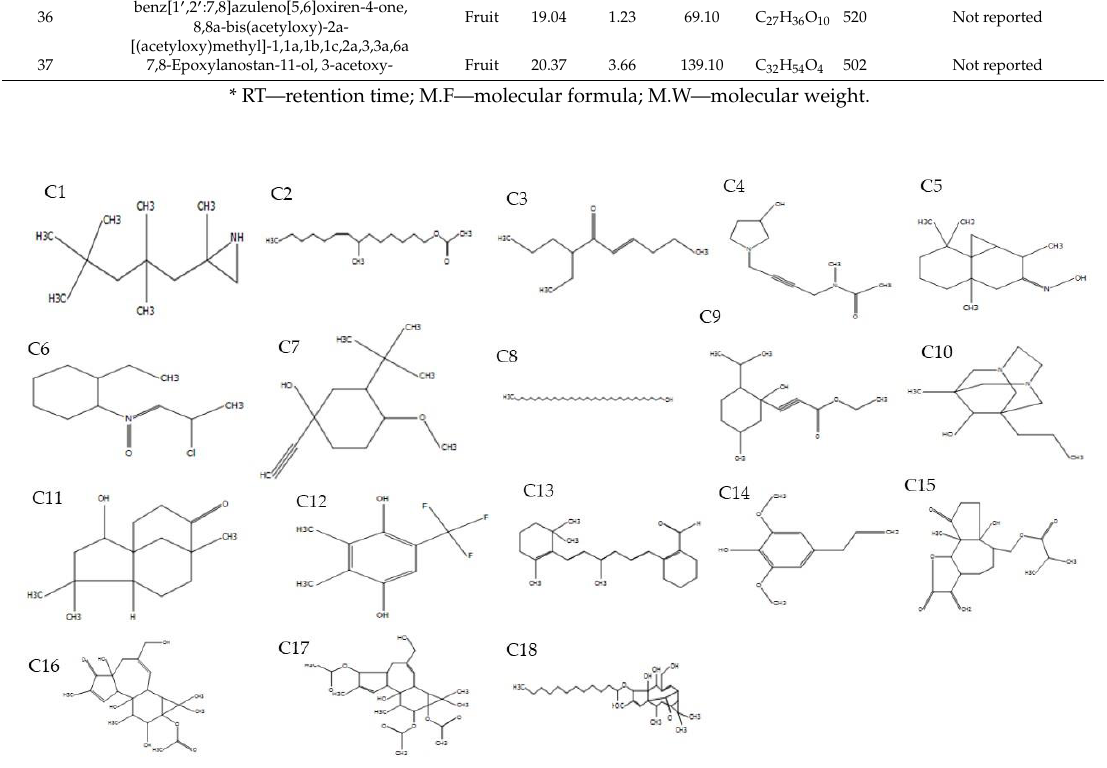
Figure 1. Chemical structures of compounds identified in ethanolic extract of A. longiloba petiole. (C1-C18). * C-compound.